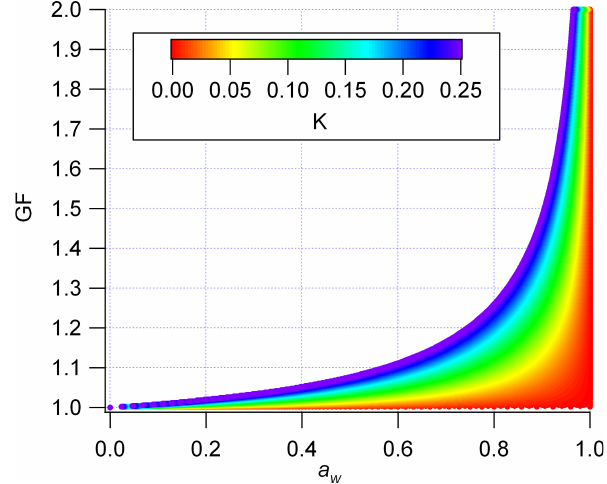
Fig. 1. Influence of the hygroscopicity parameter κ on the rela- tionship between the hygroscopic growth factor (GF) and the water activity ( a w )